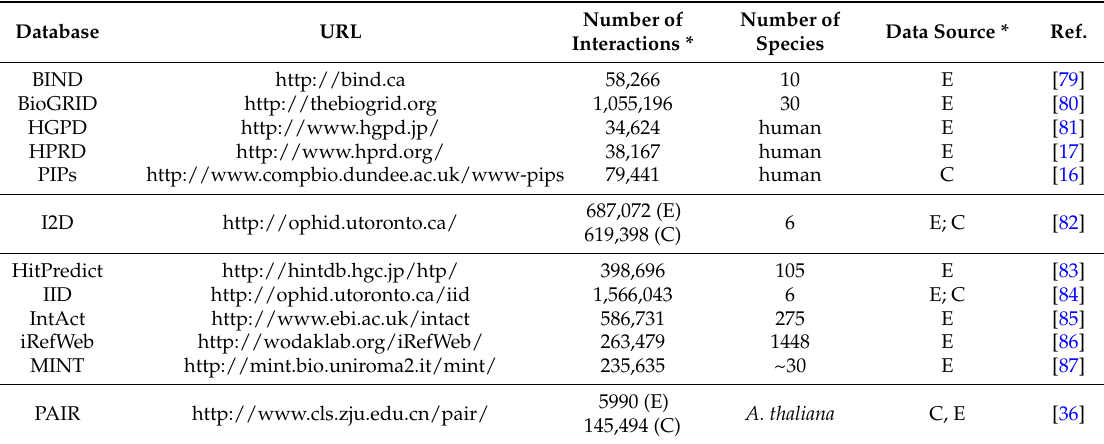
Table 1. Main databases containing large-scale